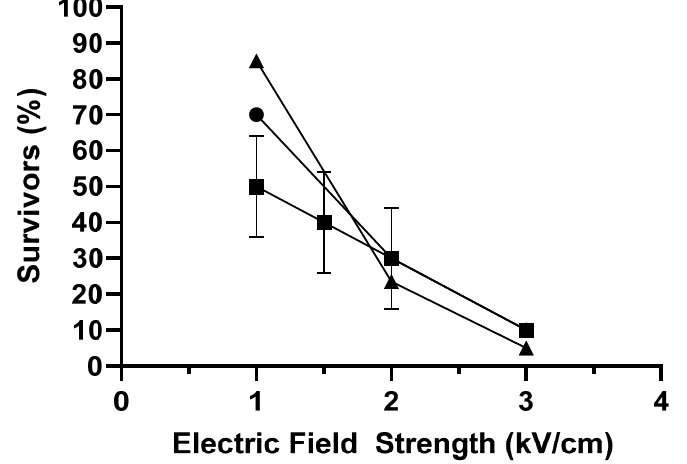
Figure 1. Influence of electric field strength on the percentage of survivors after 24 h of PEF treatments of different width and specific energy: 40 kJ/kg and 3 µ s ( • ), 50 kJ/kg and 3 µ s ( (cid:78) ), 50 kJ/kg and 50 µ s ( (cid:4)